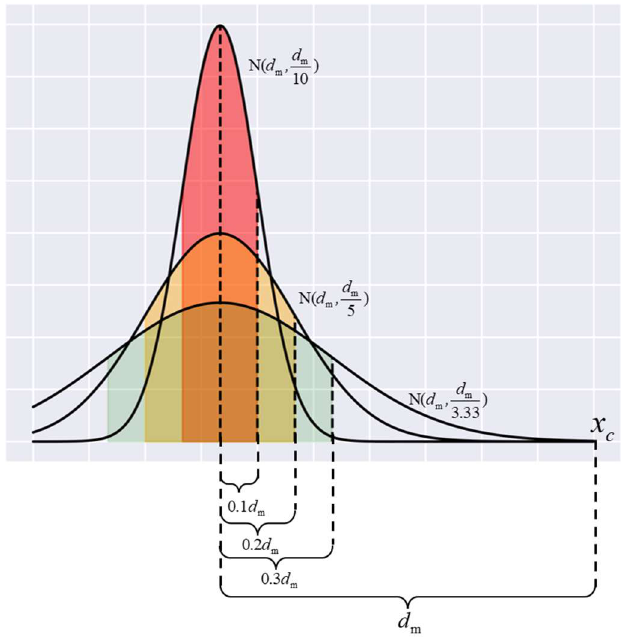
Figure 2. New samples distribution under different θ .